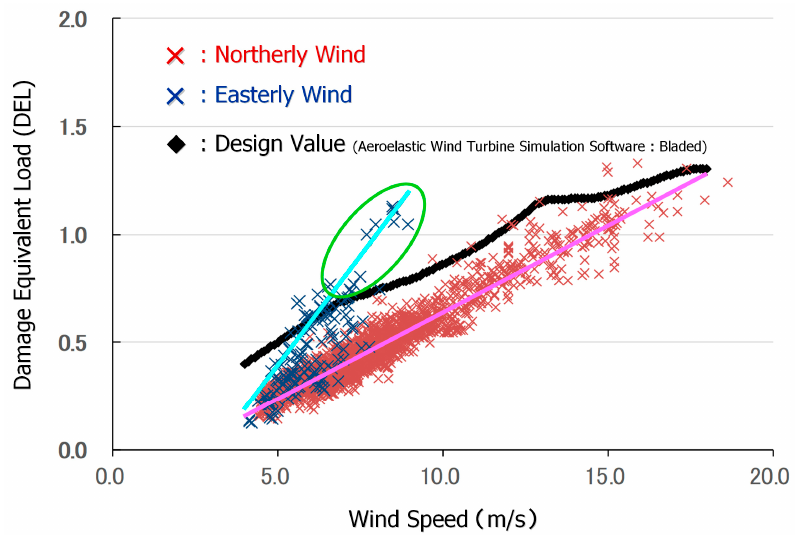
Figure 25. Relationship between wind speed (m/s) and damage equivalent load (DEL).